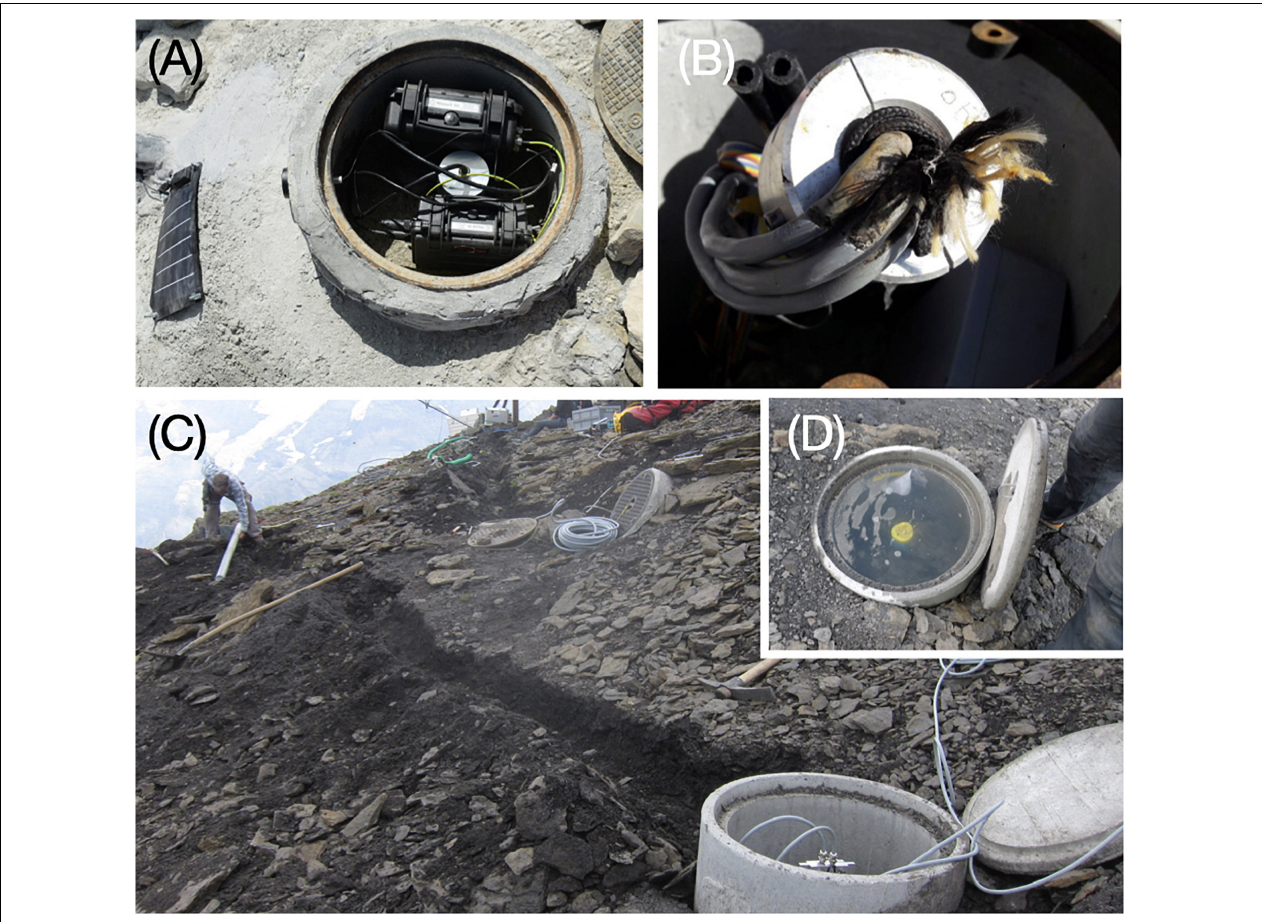
FIGURE 6 | Battery and logging system in a concrete chamber on Wisse Schijen, Switzerland ( A , photo: M. Phillips). Damaged cables due to pressure from the lid as a result of subsidence on Murtèl-Corvatsch, Switzerland ( B , photo: A. Hasler). Trench and protective casing (white casing in background of the picture) for the cables between the borehole and the instrumentation on Schilthorn, Switzerland ( C , photo: A. Hasler). Concrete chamber filled with water above the top of the borehole casing after snow melt on Schilthorn, Switzerland ( D , photo: A.